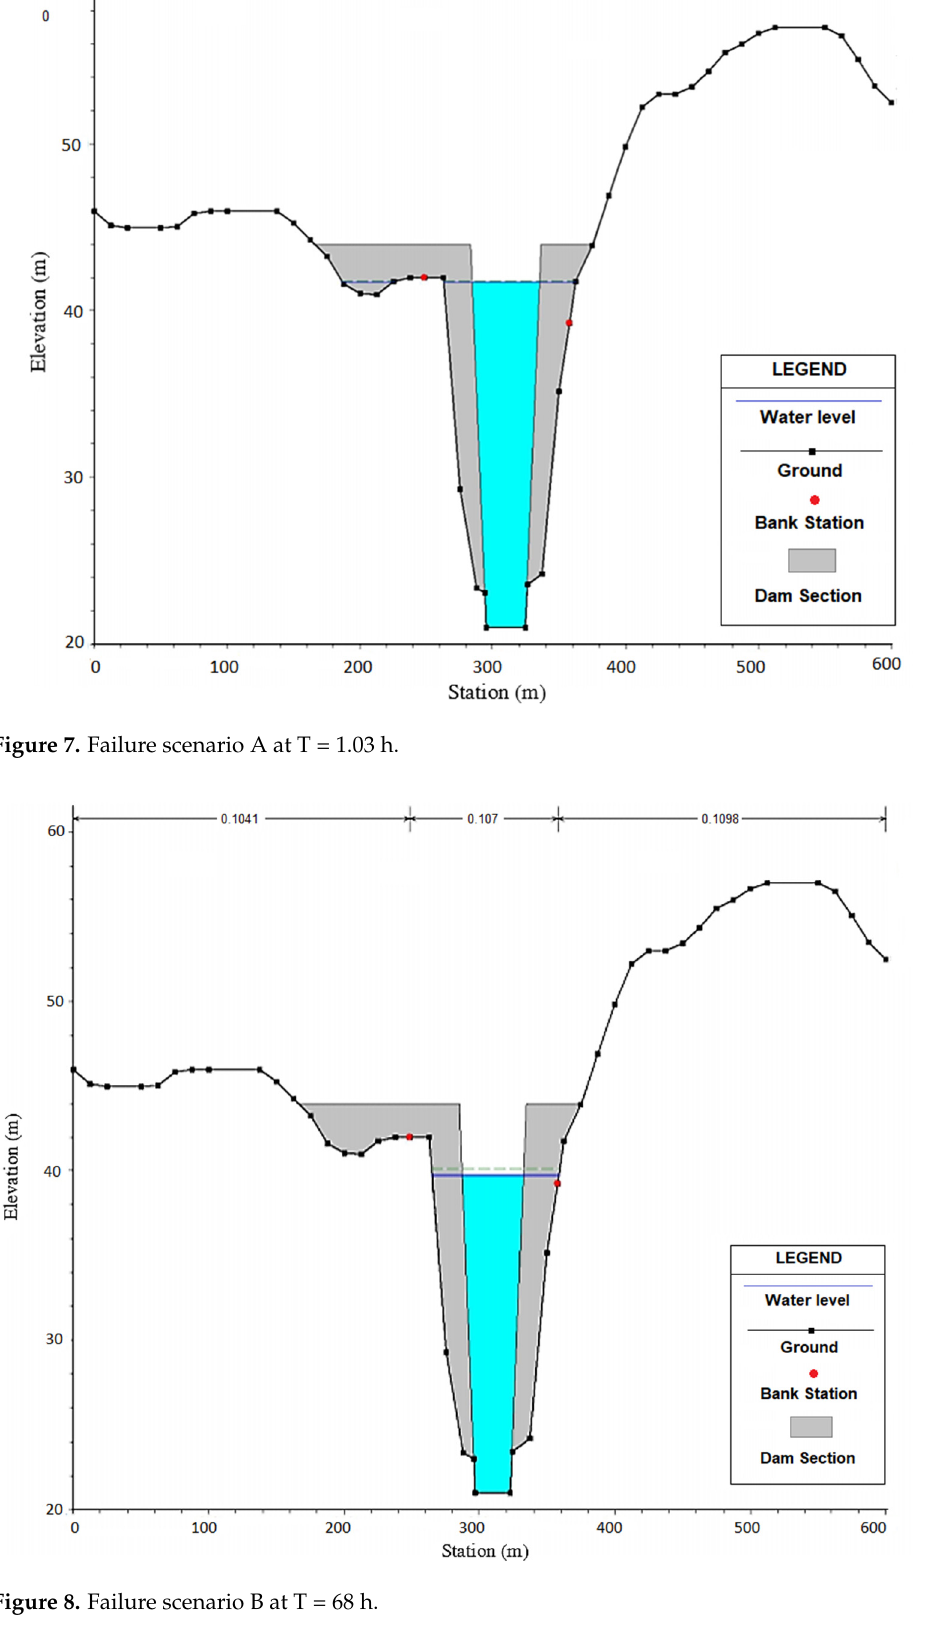
Figure 8. Failure scenario B at T = 68 h.